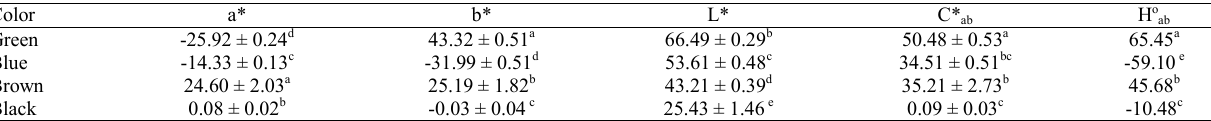
Table 1. Averages (± standard deviation) of L* (lightness), C* employed in the cultivation of the larvae of curimatá-pioa ( Prochilodus costatus ) and pacamã ( Lophiosilurus alexandri ), for 10 days. Averages in the same column followed by different letters differed significantly (P<0.05) by Tukey’s